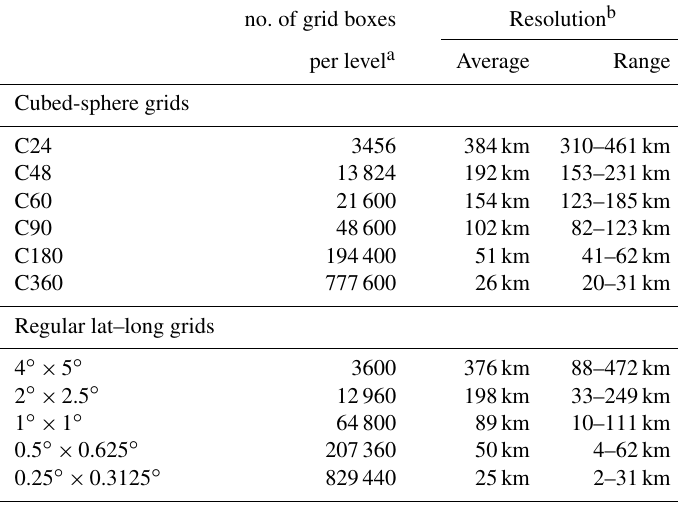
Table 1. Characteristics of various cubed-sphere grids and global latitude–longitude